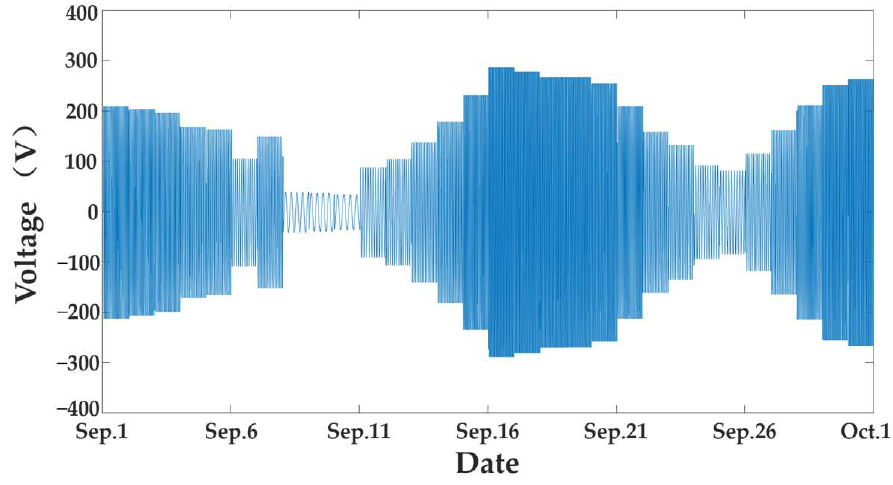
Figure 7. Monthly variation pattern of tidal power generation electricity. The EMD decomposition waveform of the tidal power monthly generation waveform is shown in Figure 8. The first three IMF signals are taken for analysis. Due to the symmetry of the signal, most of its modes are in IMF1, and the decomposition of the signal’s abrupt moments is also mirrored in IMF2 and IMF3.